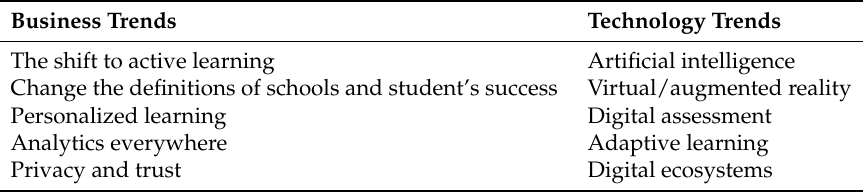
Table 1. Business and technology trends on fundamental education.